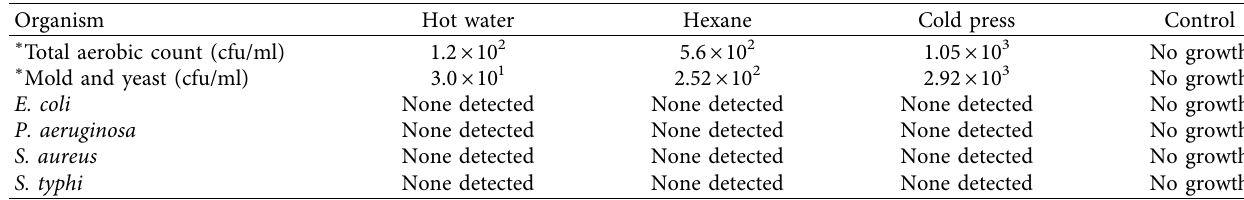
Table 2: Microbial assessment of A. foribunda butter.